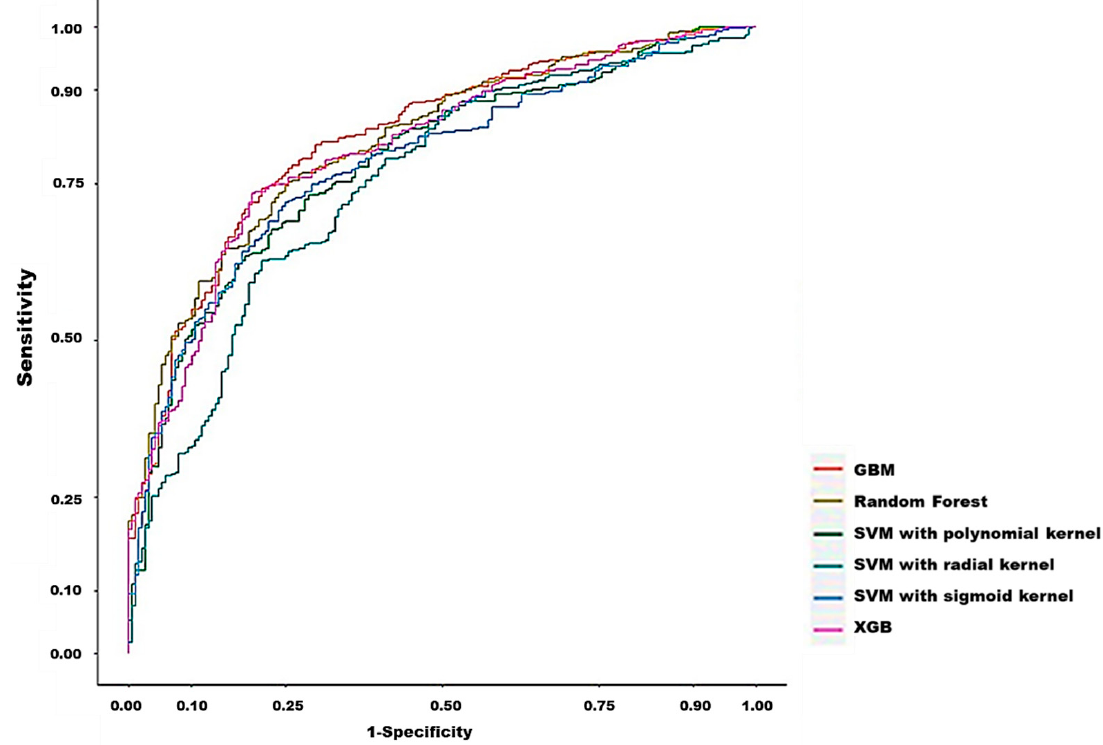
Figure 3. Receiver operation characteristic curves of the models for predicting in-hospital mortality.